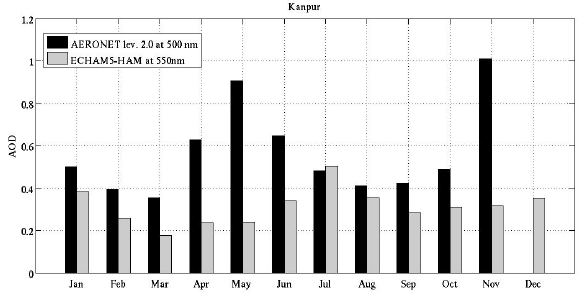
Fig. 15. AOD at Gandhi College from AERONET point measurement in year 2006 at λ = 500nm (black) and as a grid box four-year average from ECHAM5-HAM data using 2006 emissions at λ = 550nm (grey).